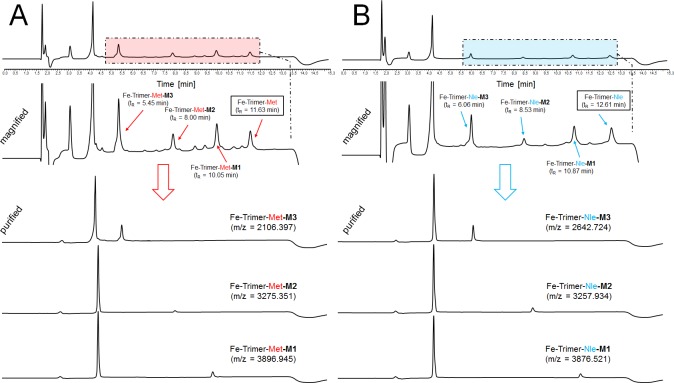
In vitro metabolite assessment, purification and identification of non-radioactive metabolites formed by artificial enzymatic degradation.Representative RP-HPLC chromatograms (UV absorption at λ = 220 nm) of enzymatic degradation of Fe-Trimer-Met (A) and Fe-Trimer-Nle (B). Below the arrow chromatograms of purified main metabolites are shown including molecular weight of corresponding mass analysis.